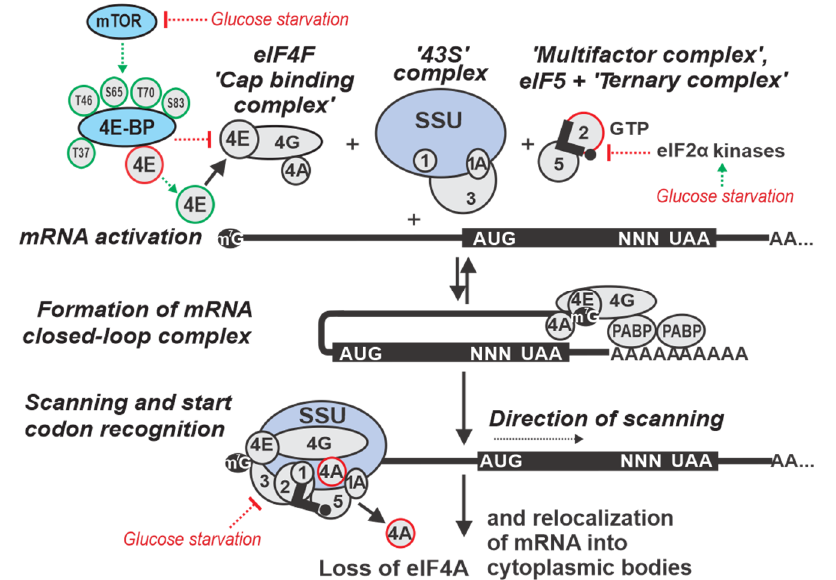
Figure 1. Overview of the major stages of cap-dependent translation initiation involved in the translational response to glucose deprivation. Suppressed pathways are depicted in red; activated pathways are depicted in green. SSUs shown in light state grey, initiation factors in silver, regulatory proteins and complexes not normally considered as initiation factors in light sky blue.